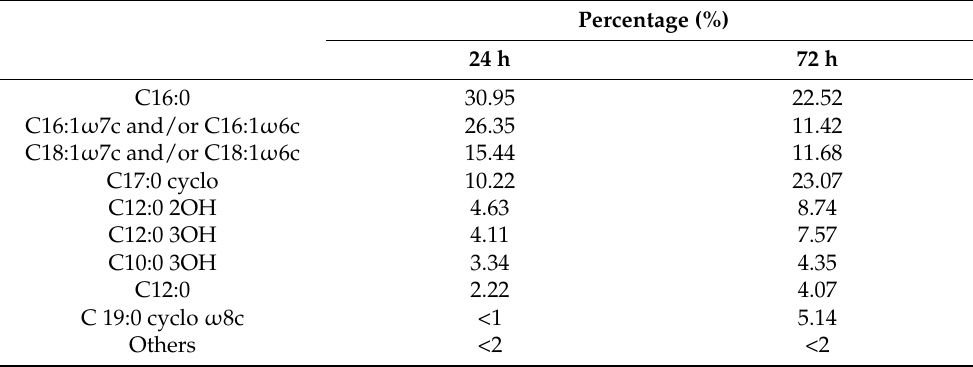
Table 2. Fatty acid composition (%) of the ZCR6